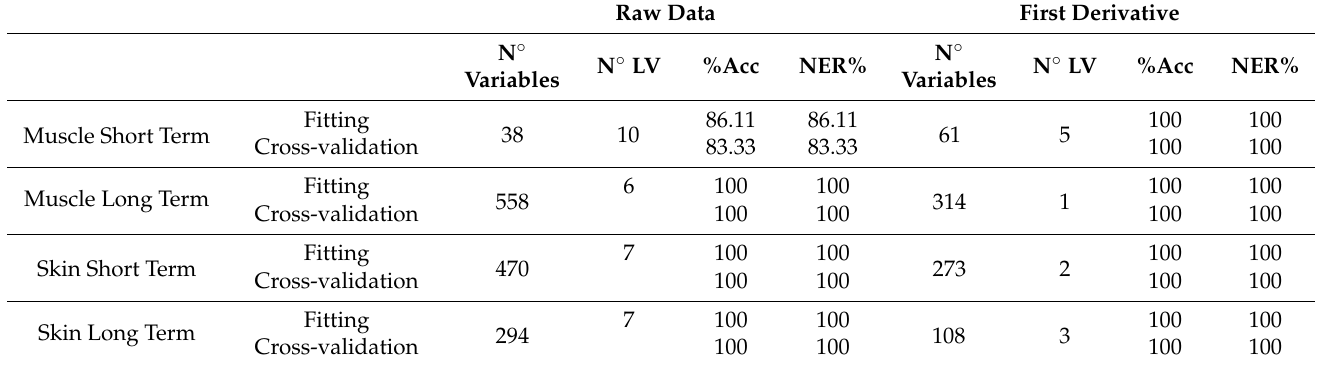
Table 1. PLS-DA classification results for the four comparisons investigated: N ◦ of variables and LVs included in each model, %Accuracy (%Acc) and NER%, both in fitting and cross-validation, for the models built on raw data or on first derivative data. Cross-validation was applied with 6 cancellation groups taking out at the same time all the replications of the samples analyzed the same day (1 control and 1 treated fish, 6 total